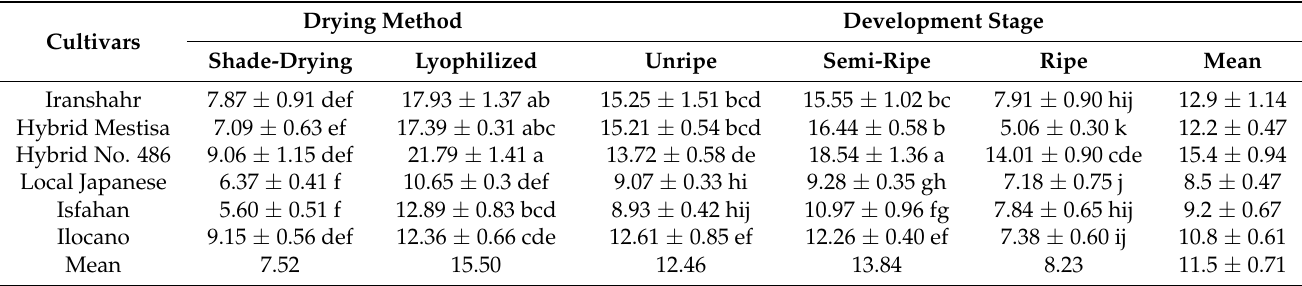
Table 9. Cultivar × drying method and cultivar × development stage interaction effects on fruit charantin content ( µ g/g). Cultivars